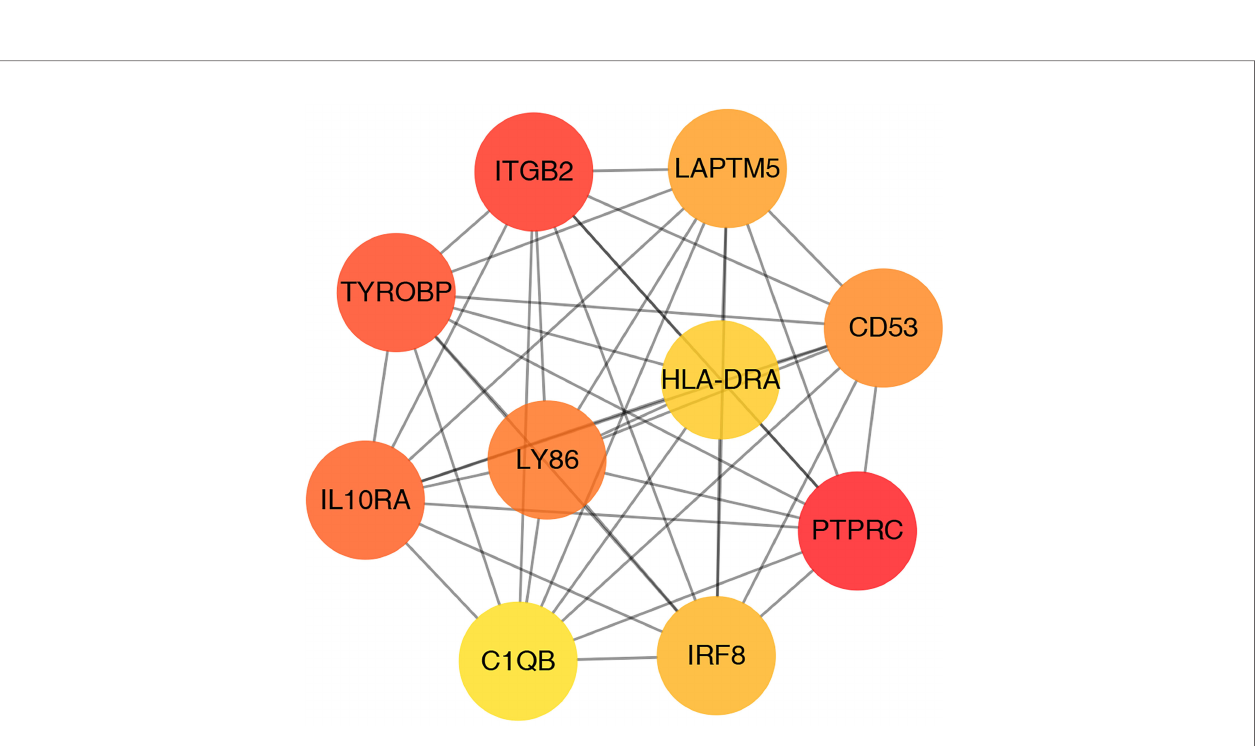
FIGURE 5 | Screening of hub genes.